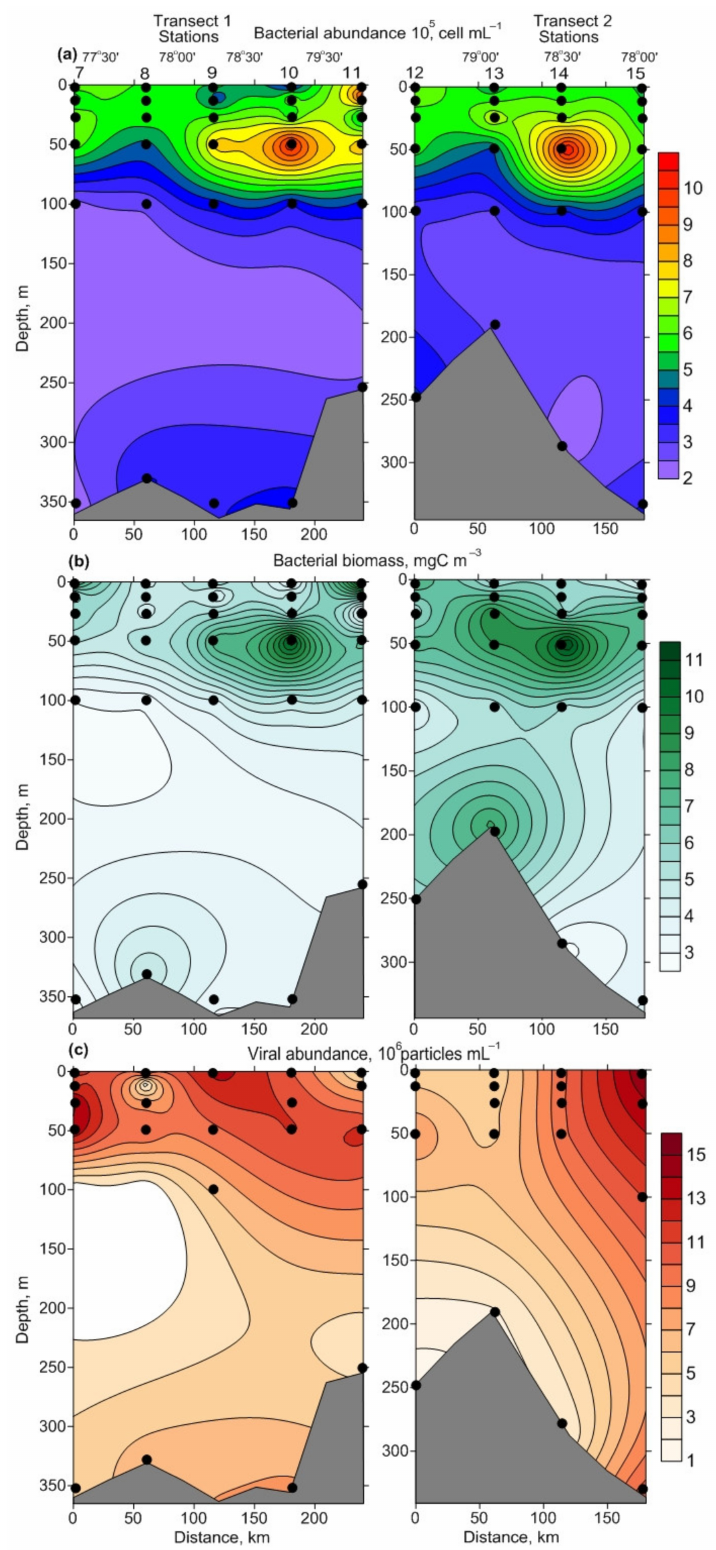
Figure 4. Vertical profiles of bacterial abundance (( a ), 10 5 cells · mL − 1 ), bacterial biomass (( b ), mgC · m − 3 ), and viral abundance (( c ), 10 6 particles · mL − 1 ), along the transects preformed